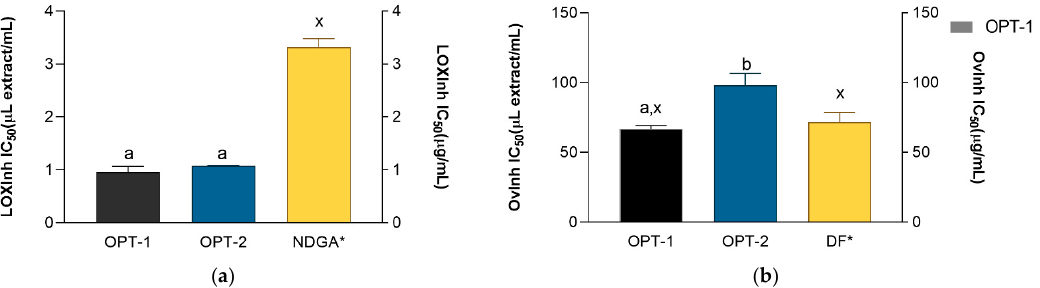
Figure 5. Lipoxygenase-( a ) and ovalbumin coagulation inhibitory ( b ) activity of the OPT-1 and OPT-2 extracts (prepared as described in Section 2.6) and positive controls NDGA (nordihydroguaiaretic acid) and DF (diclofenac). a,b = differences between the extracts within a column (Student’s t -test, p < 0.05). x = differences with the positive control (ANOVA followed by Dunnett’s post-test, p < 0.05). Columns not connected with the same letter are statistically different. The asterisk indicates that the unit is placed at the right ordinate.